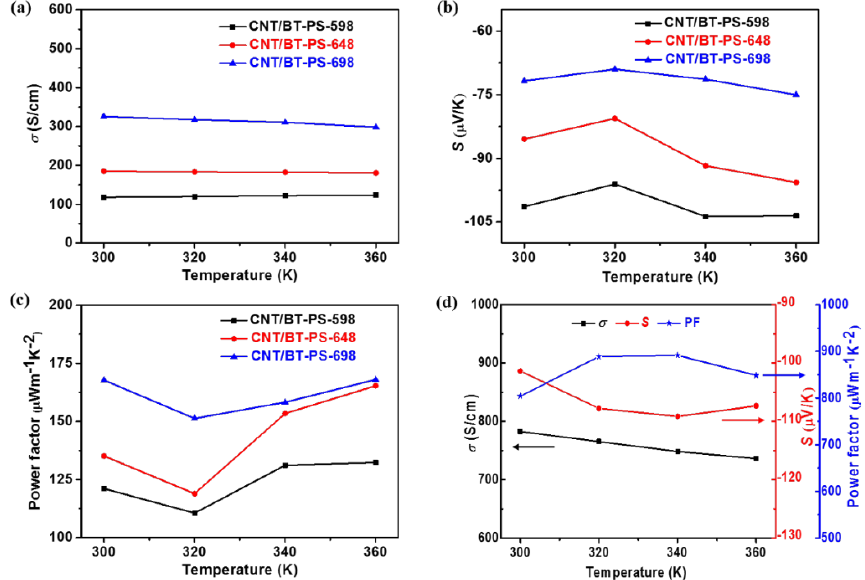
Figure 5. ( a ) Temperature dependence of electrical conductivity, ( b ) Seebeck coefficient, and ( c ) power factors of CNT/BT-PS-598, CNT/BT-PS-648, and CNT/BT-PS-698. ( d ) Temperature dependence of electrical conductivity, Seebeck coefficient, and power factor of CNT/BT-HP-648.